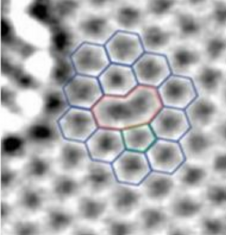
Figure 1. Graphene single hole defect (reprinted with permission from [21]. Copyright 2012 American Chemical